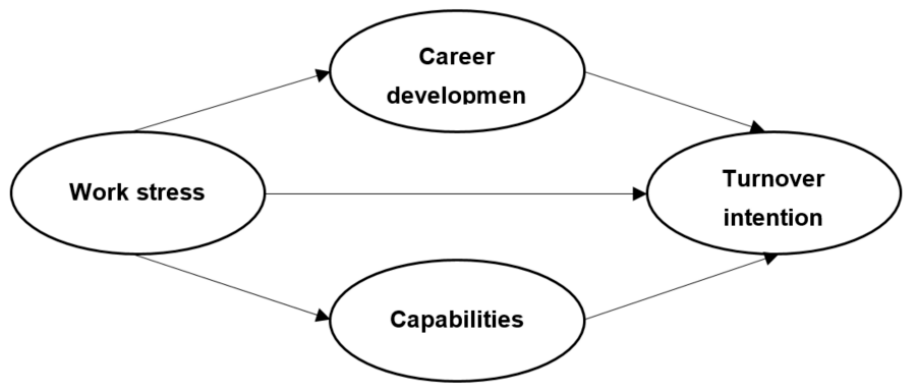
Figure 1. Research